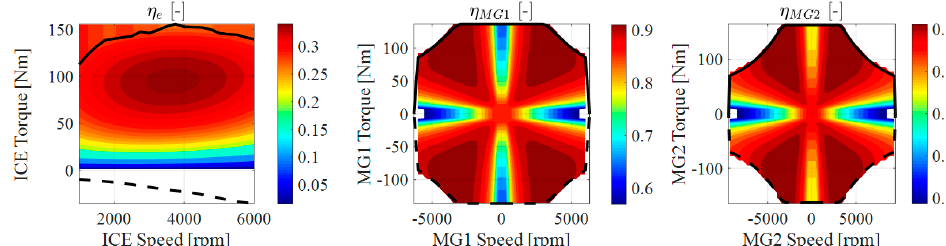
Figure 5. Efficiency maps, maximum (black solid lines) and minimum (black dashed lines) torque characteristics for the engine ( left ), the MG1 ( center ) and the MG2 ( right ) of the EVT two-mode hybrid system.